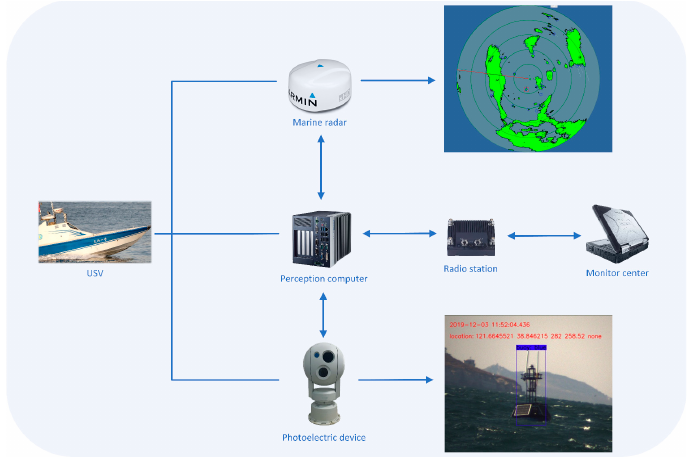
Figure 2. USV perception system.